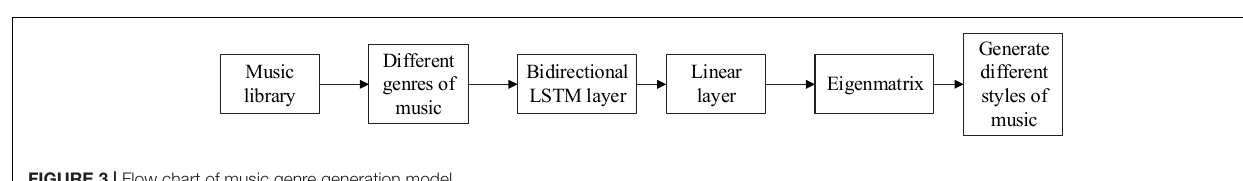
FIGURE 2 | Flow chart of data preprocessing.